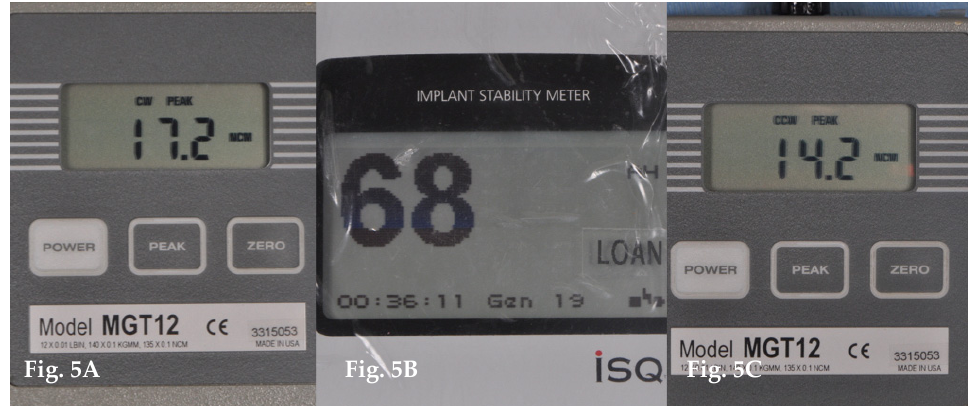
Figure 5. ( A ) Data recording of Peak insertion torque (PIT); ( B ) Data recording of Resonance frequency analysis (ISQ); ( C ) Data recording of Peak removal torque (PRT).